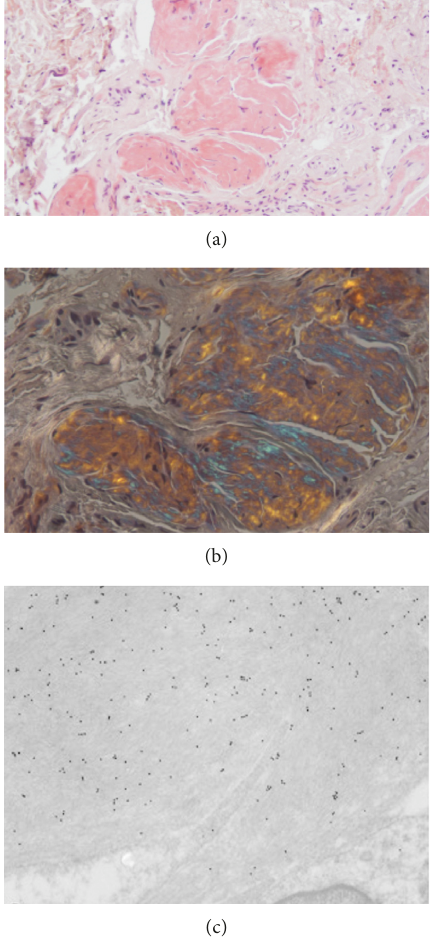
Figure 3: Presence of amyloid in the salivary gland. (a) Hema- toxylin and eosin staining: some more dark areas between the muscle fibers are observed ( × 10). Olympus Bx51 optical micro- scope. (b) Congo red staining with polarized light: apple green birefringence. (c) Postembedding immunostaining: amyloid fibrils are intensely and specifically immunostained with anti-kappa light chain antibody (Dako, 1 : 100). Jeol JEM-1400 Plus electron microscope.